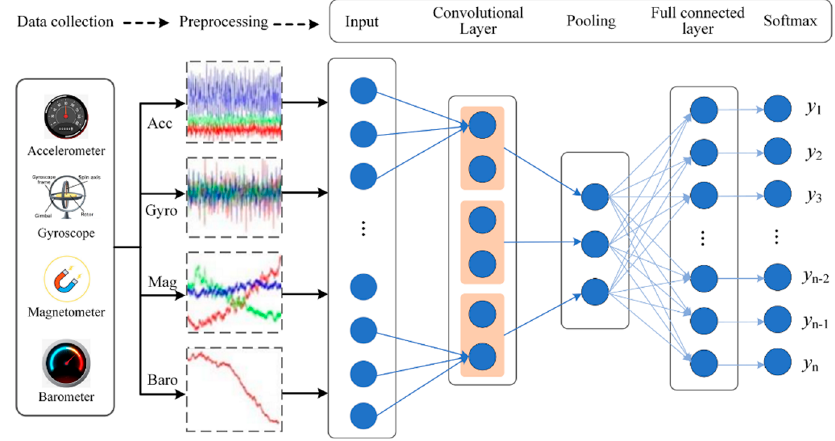
Figure 4. The workflow of the proposed CNN-based method.